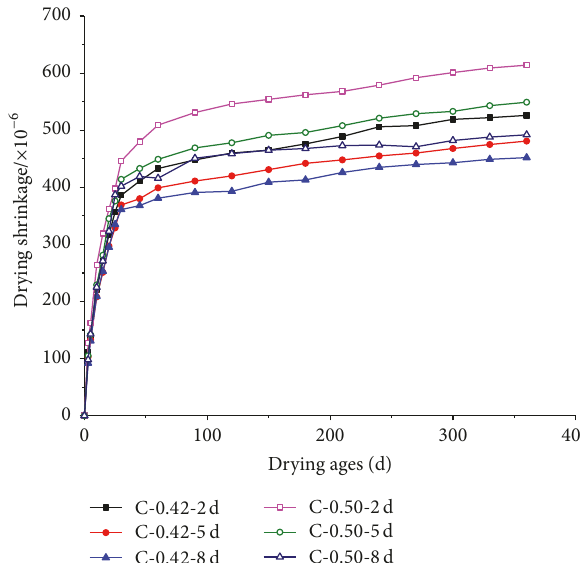
Figure 1: Drying shrinkage of plain cement concrete.